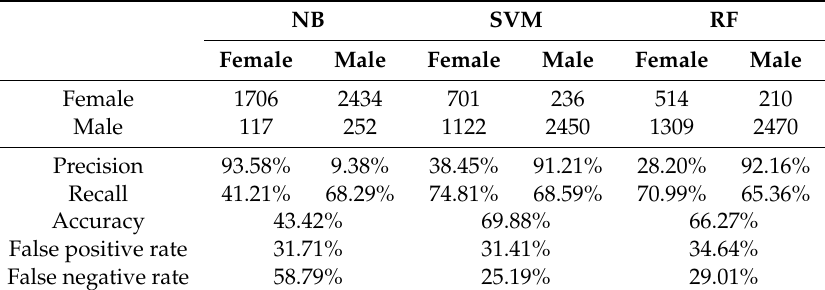
Table 5. The accuracy of gender detection using senti-word feature set.